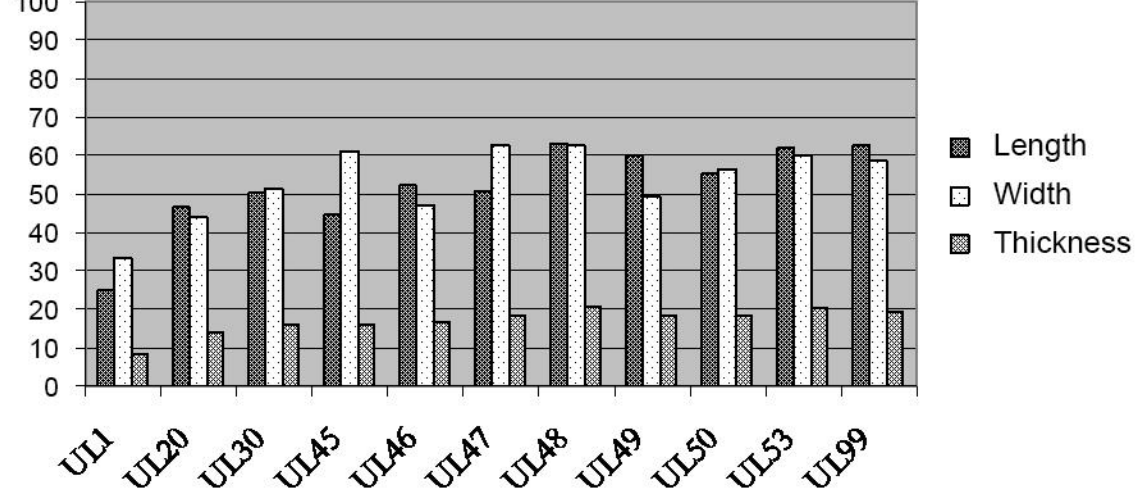
Figure 10. Flake dimensions (mm) distributed by the lithological units that contained flakes.